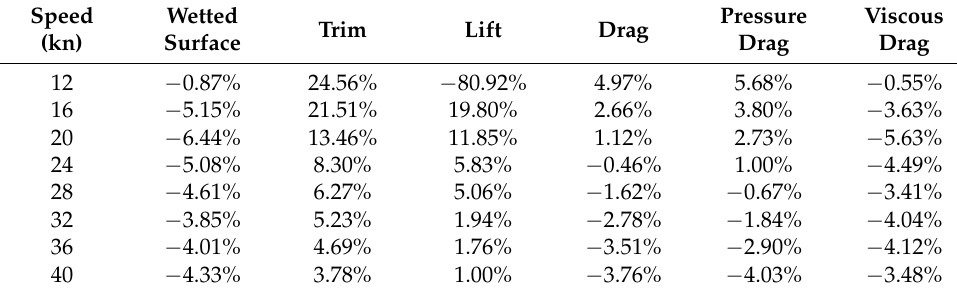
Table 19. Comparison of lift computed on